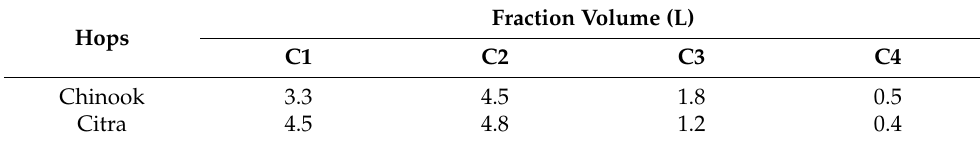
Table 5. Recovered condensed extract volume for each column at the end of the extraction process.